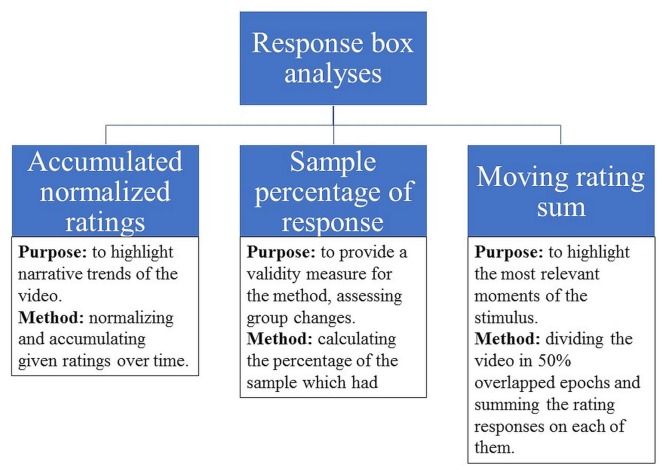
Likeability indicators processing summary.